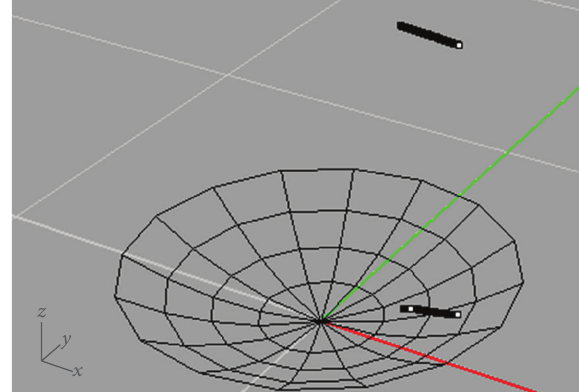
Figure 8: Graphical representation of function (7) over a concave surface.